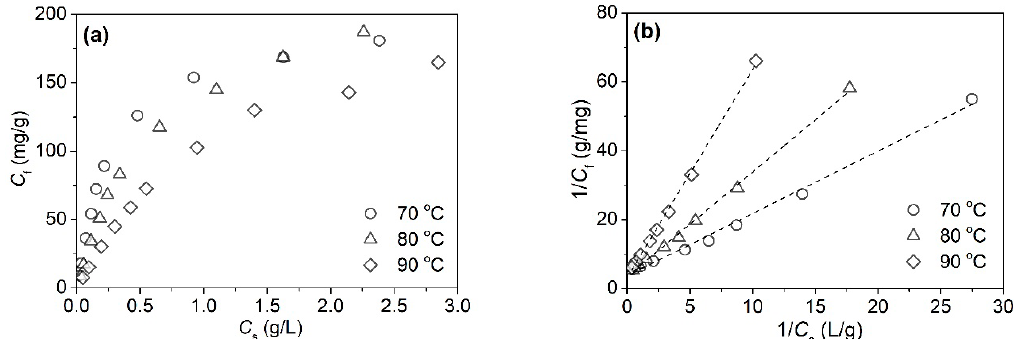
Figure 5. Adsorption isotherms ( a ) and Langmuir fitted curves ( b ) of tannic acid on silk fiber at three temperatures.